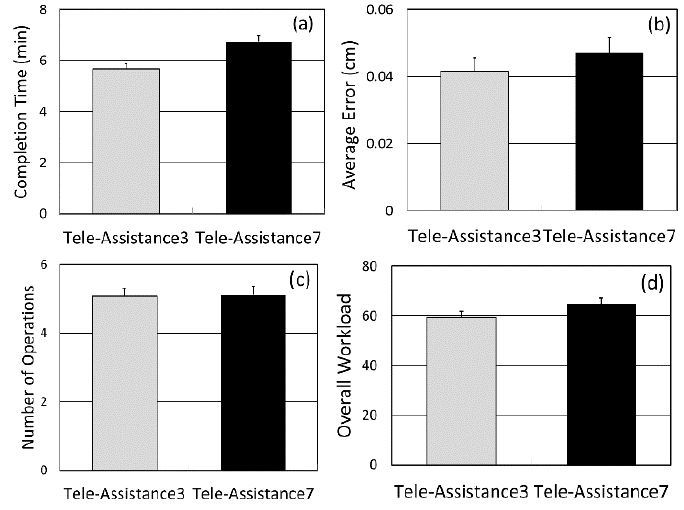
Figure 7. Results of Experiment III: ( a ) Average completion time of the task; ( b ) Average error of performing the task; ( c ) Average number of operations executed by the participants; ( d ) Average workload perceived by the participants. (Error bars represent standard error.)